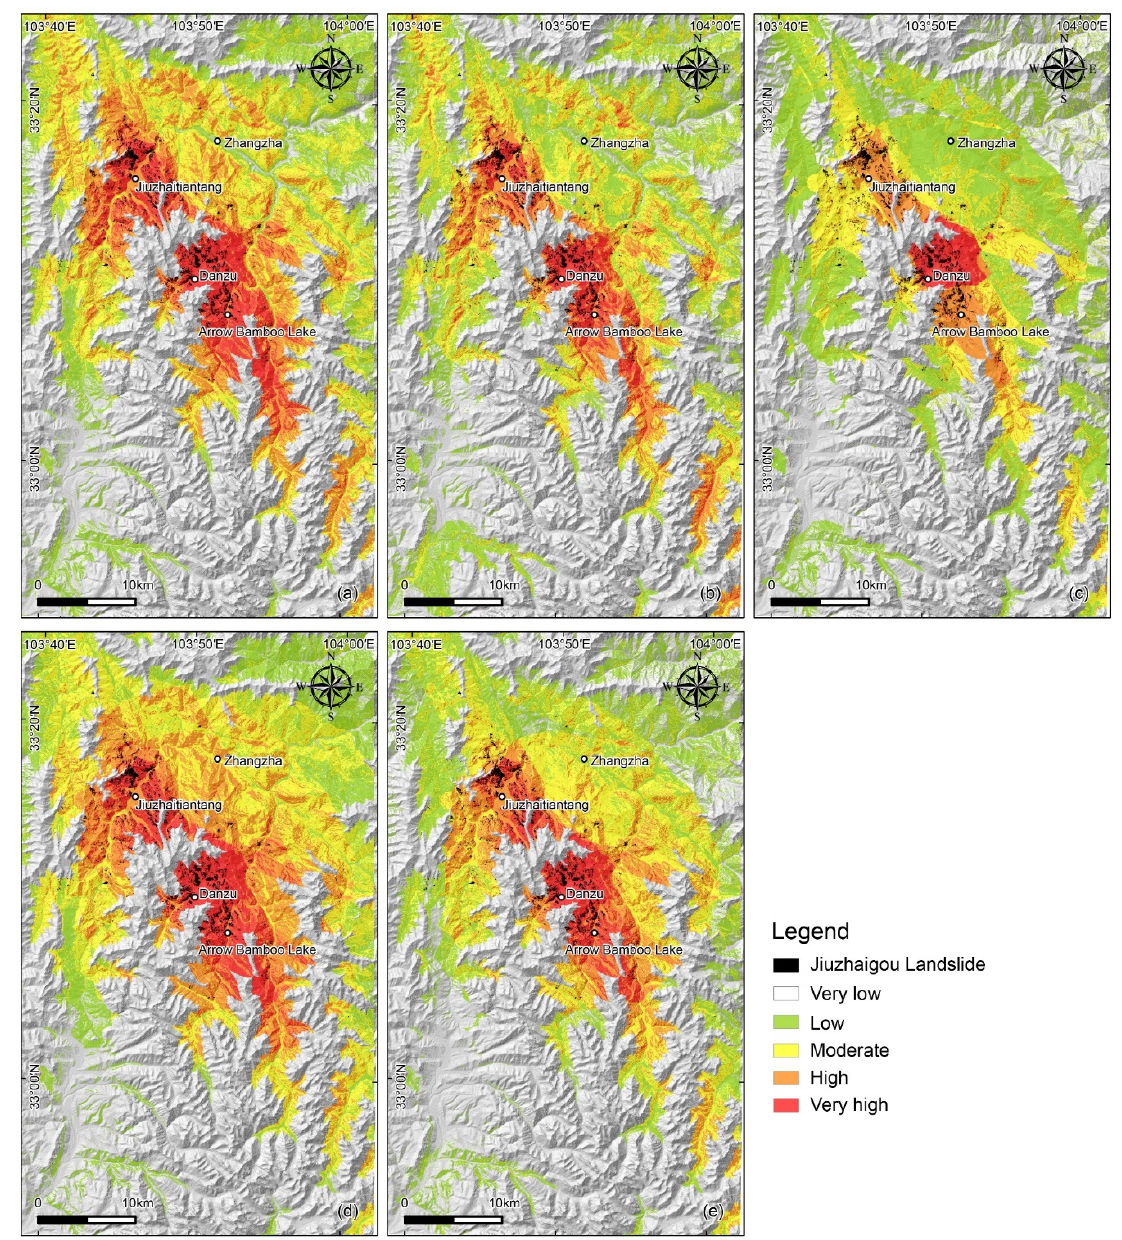
Figure 8. Distribution map of earthquake landslide susceptibility in Jiuzhaigou area. ( a ) Information model; ( b ) CF model; ( c ) LR model; ( d ) I + LR model; ( e ) CF + LR model.